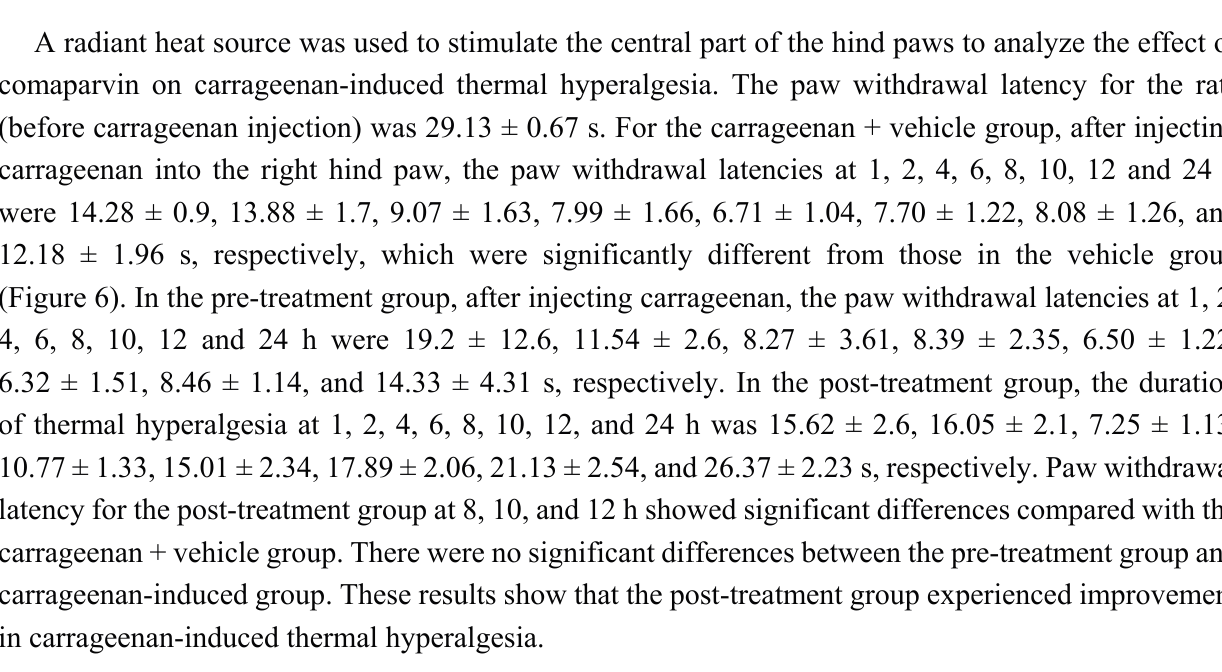
Figure 6. Time course showing the effects of comaparvin on carrageenan-induced thermal hyperalgesia. Comaparvin (30 mg/kg) was administered 4 h after carrageenan injection (post-comaparvin) and significantly inhibited carrageenan-induced thermal hyperalgesia at 8, 10, 12, and 24 h. Pre-comaparvin, pre-treatment of comaparvin at 1 h before carrageenan injection. Post-comaparvin, comaparvin post-treatment at 4 h after carrageenan injection. Data are the mean ± SEM values. * p < 0.05, significant difference compared with the carrageenan + vehicle